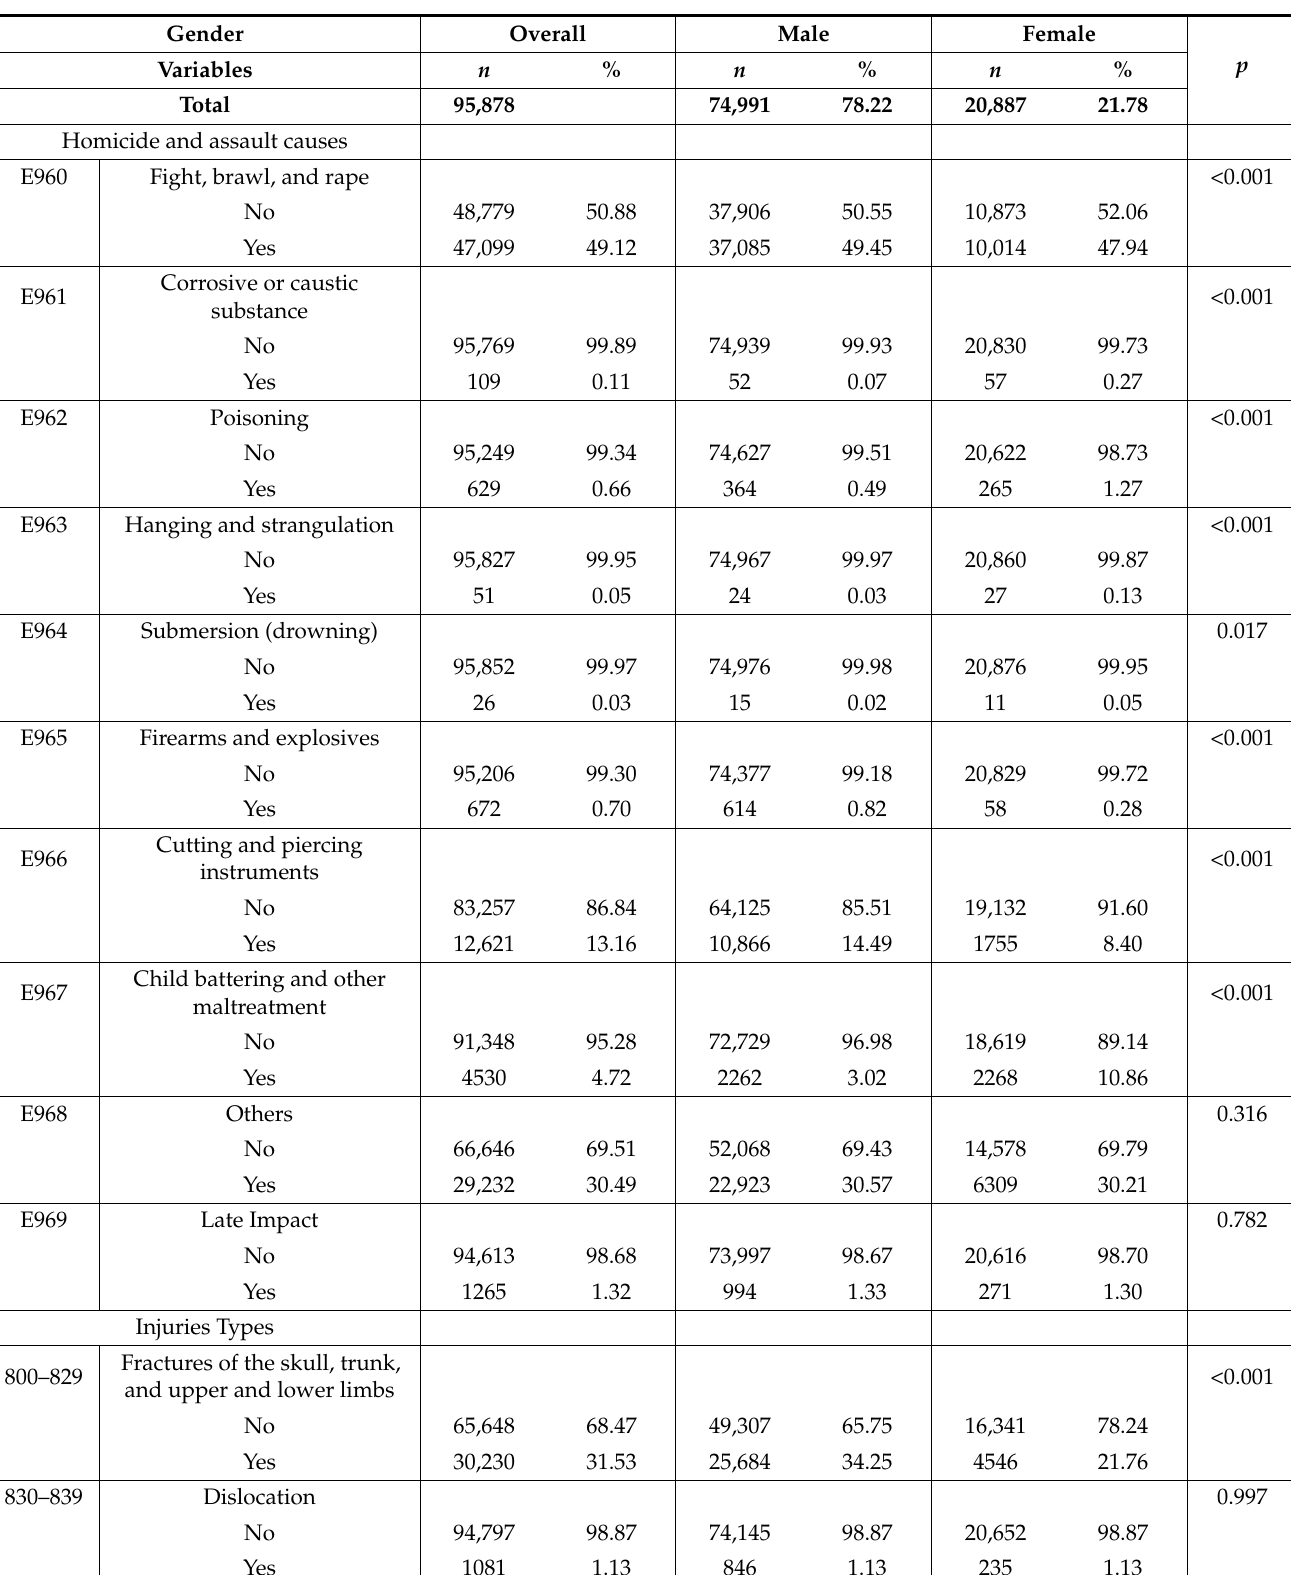
Table 2. Comparison of injury types of patients hospitalized due to homicide and assault in Taiwan,